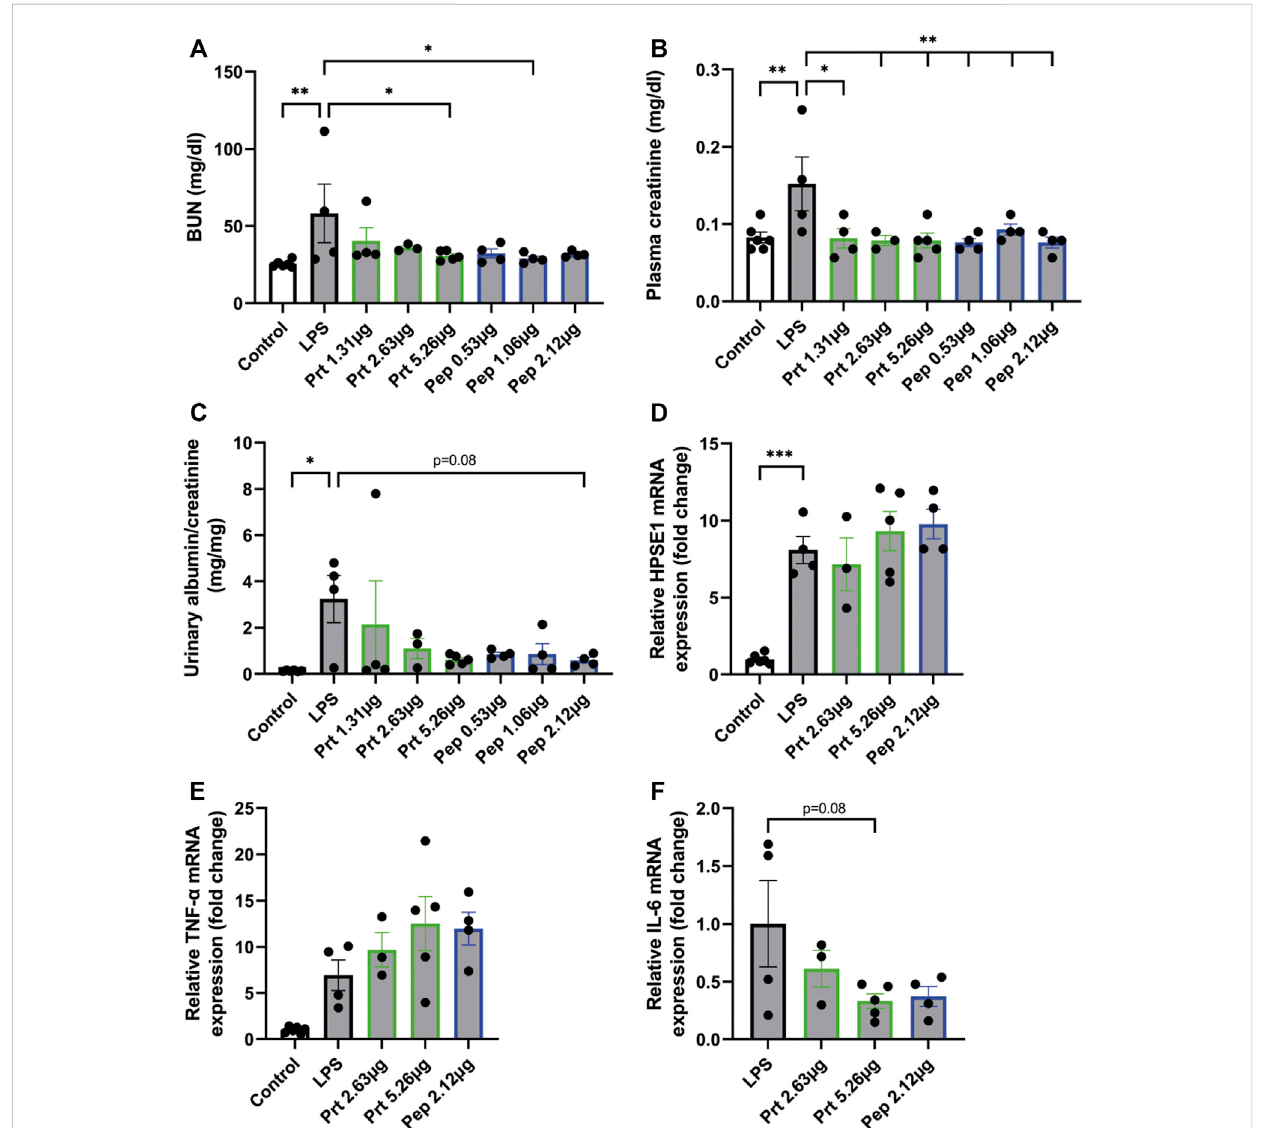
FIGURE 5 HPSE2 protein and peptides treatment have bene fi cial effects in LPS-induced glomerulonephritis (A) . BUN, (B) . plasma creatinine, and (C) . Urinary albumin/creatinine ratio of mice injected with LPS (2 days) and treated with different concentrations ofHPSE2 protein or HPSE2 peptide mix (D) . Cortical HPSE1, (E) . cortical TNF- α , (F) . cortical IL-6 mRNA expression of mice injected with LPS (2 days) and treated with different concentrations of HPSE2 protein or HPSE2 peptide mix of 381 – 410, 391 – 420, and 401 – 430. Data are expressed as mean ± SEM. n ≥ 4 * p < 0.05, ** p < 0.01, *** p < 0.001. HPSE2, heparanase-2; HPSE1, heparanase-1; Prt, His-mHPSE2 protein; pep, HPSE2 peptide mix of 381 – 410, 391 – 420, and 401 – 430; BUN, Blood urea nitrogen plasma